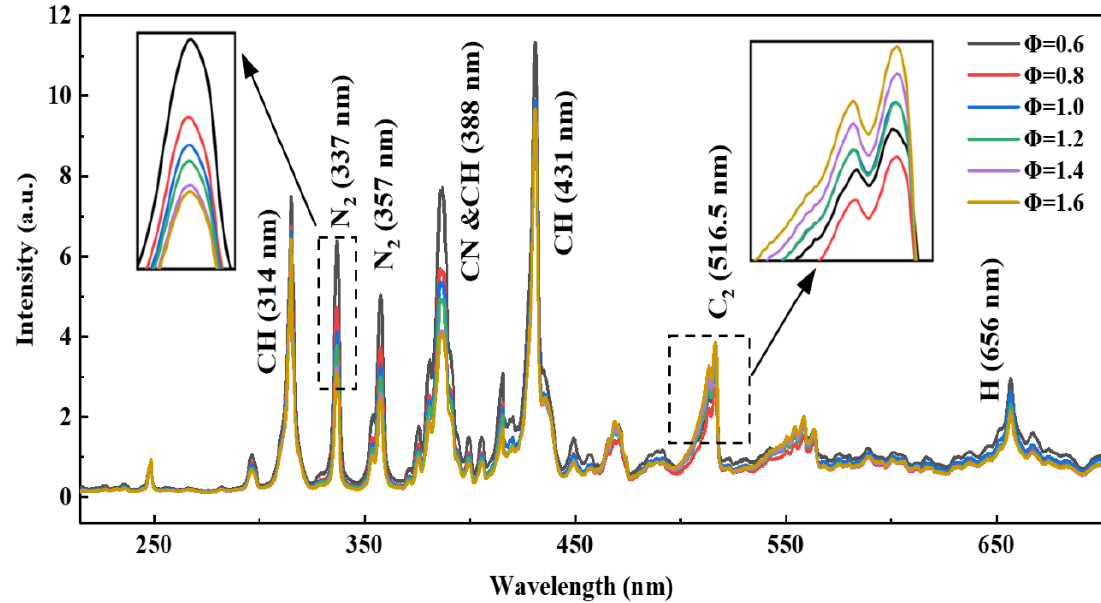
Figure 3. Spectral curves of fs laser-induced filament in CH 4 /air mixture at different equivalence ratios. The insets show the locally enlarged view of the N 2 (337 nm) and C 2 (516.5 nm) signals.